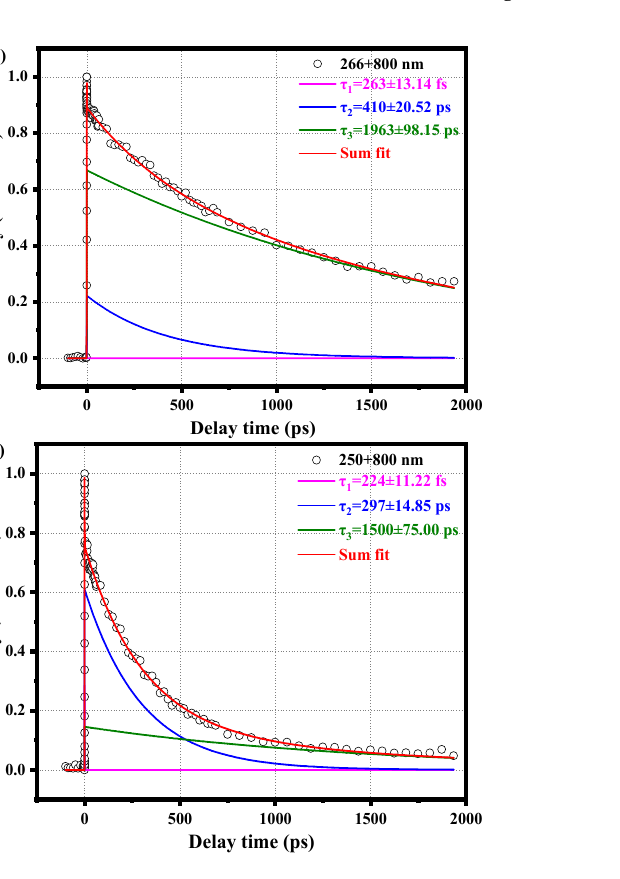
Figure 5. Time decay curves of the parent ion measured with ( a ) 266 nm pump pulse and 800 nm probe pulse, ( b ) 260 nm pump pulse and 800 nm probe pulse, ( c ) 250 nm pump pulse and 800 nm probe pulse, and ( d ) 240 nm pump pulse and 800 nm probe pulse. The circles are experimental data, and the solid lines are fitted data. All curves are fitted using a Gaussian cross-correlation function and a convolution of three exponential decay functions to obtain different decay